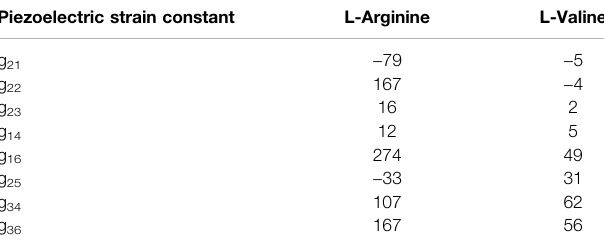
TABLE 4 | DFT-predicted piezoelectric voltage tensor components of L-Arginine and L-Valine single crystals. All values are in mV